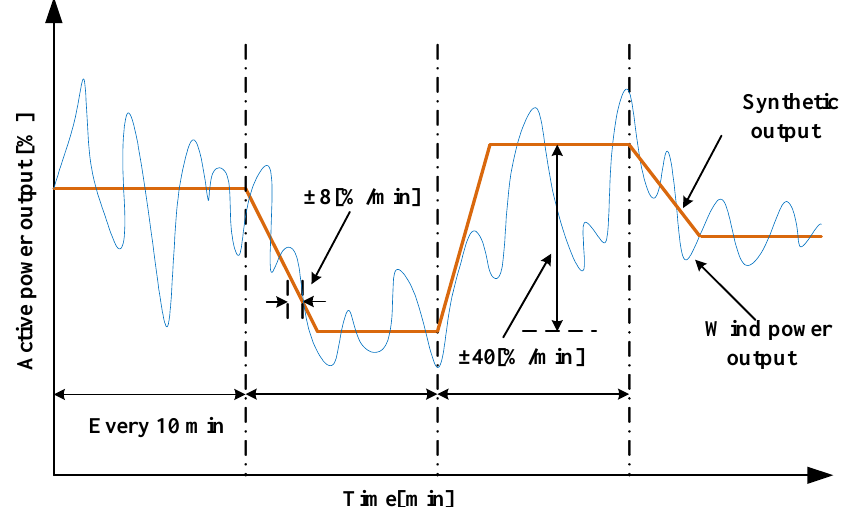
Figure 8. 1-min and 10-min RRL